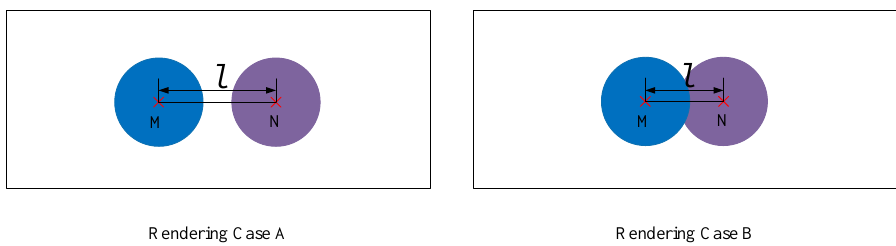
Figure 5. The two kinds of rendering cases involved in rendering process of radar image generation